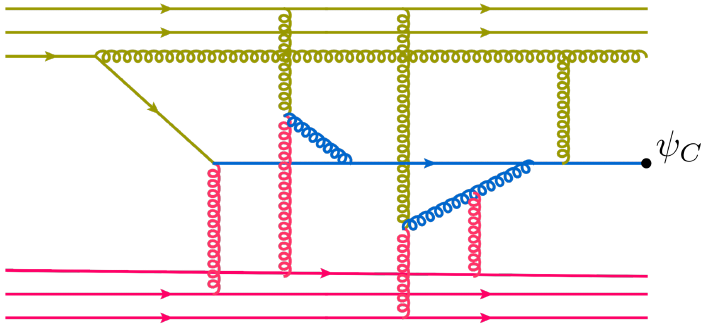
Figure 2 . Typical diagram for the classical field with projectile/target sources. The Green functions of central fields are given by retarded